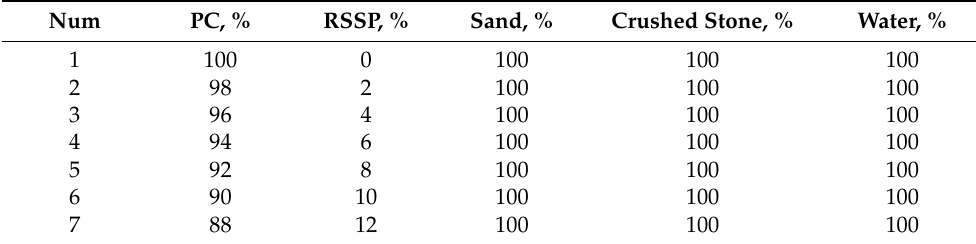
Table 3. Dosage of the nanomodifying additive.